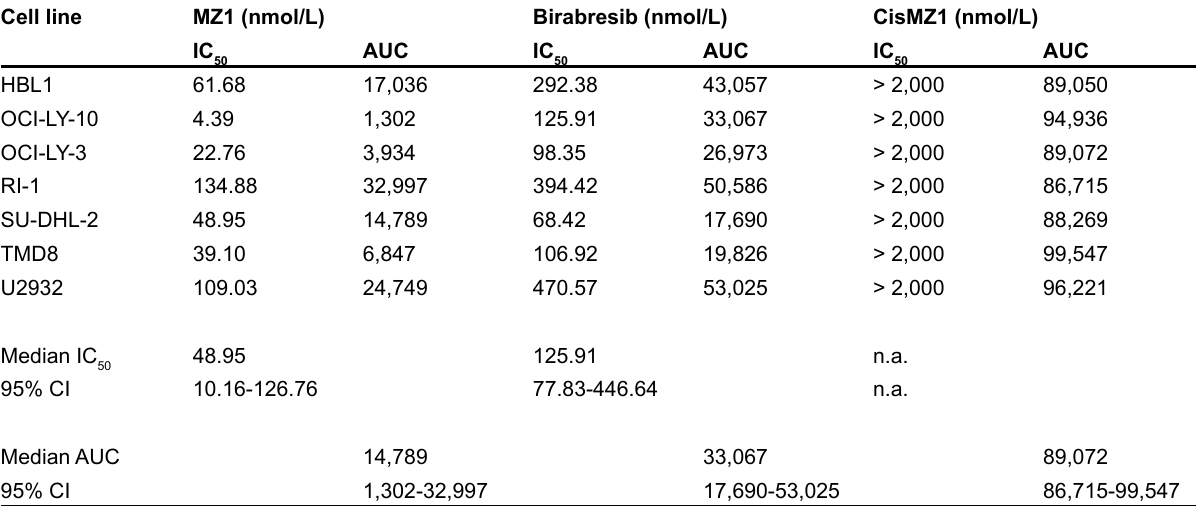
Figure 1. Activity of MZ1, birabresib and cisMZ1 in ABC DLBCL cell lines. A. Seven ABC DLBCL lymphoma cell lines were exposed to increasing concentrations of MZ1, birabresib or cisMZ1 for 72 h. IC and AUC were calculated and showed in the in 50 the box plots; B. cell cycle effects observed after 24 h and 72 h of treatment of OCI-LY-10 cells with birabresib, MZ1 and cisMZ1 (500 nmol/L); C. representative plots obtained after 72 h of treatment at 500 nmol/L; D. apoptotic effect of the BET degrader MZ1 and birabresib in four ABC DLBCL cell lines tested at their IC s, as in Table 1. Early and late apoptotic effect for 72 h was 50 evaluated. DMSO vs. birabresib, P < 0.05. DMSO treatment was used as a control. MZ1, cisMZ1 and birabresib were dissolved in DMSO and maximum 0.1% DMSO was used for treatments. The Mann-Whitney U test was used to compare groups. * P < 0.05; *** P < 0.001 Table 1. Activity of MZ1, birabresib and cisMZ1 in ABC DLBCL cell